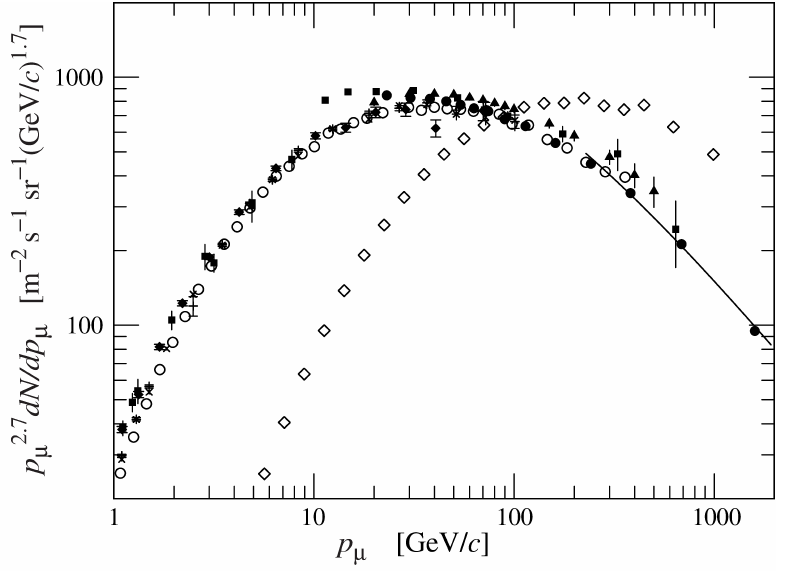
Figure 1. Energy spectra of muons at 0 ◦ (black dots) and at 75 ◦ (white dots) as in